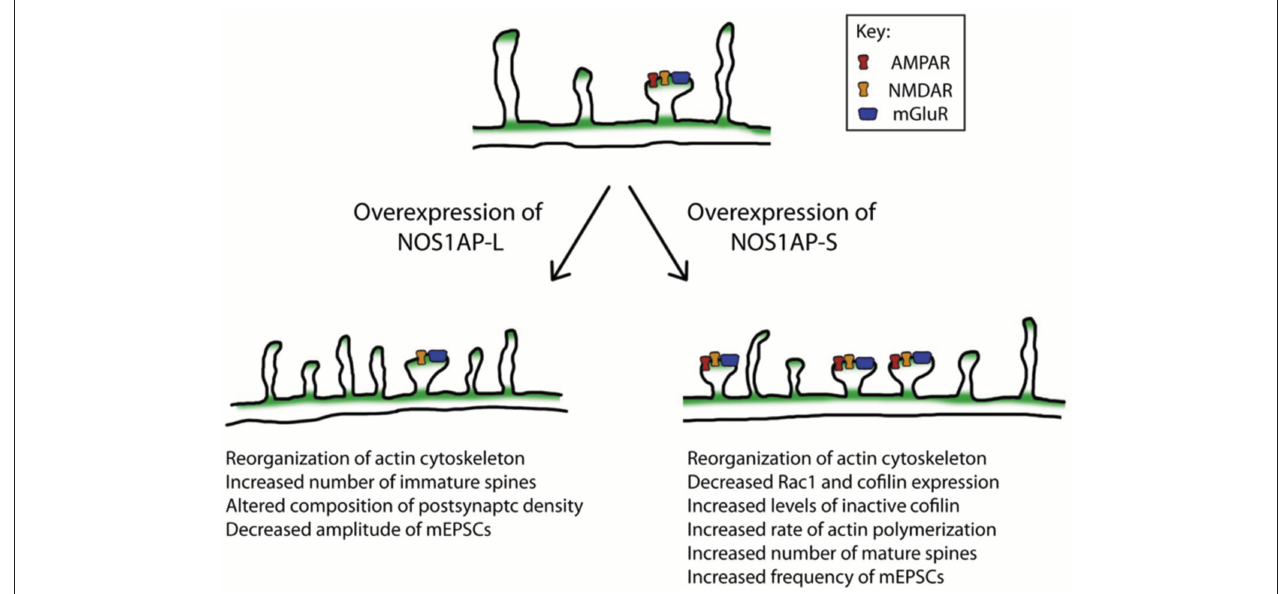
FIGURE 8 | Model of the actions of NOS1AP-L and NOS1AP-S on the actin cytoskeleton, dendritic spine number and maturity, and synaptic strength. Overexpression of NOS1AP isoforms result in distinct changes to neurons. A model of action for NOS1AP-L and NOS1AP-S is shown.